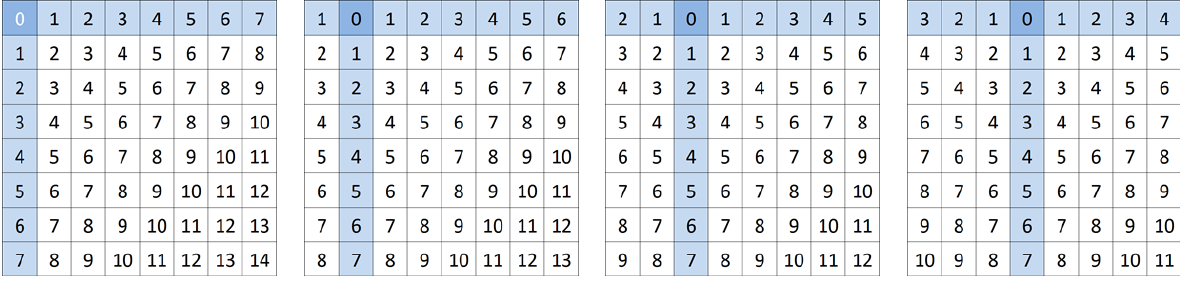
Figure 2. Number of moves required to move the blank to each position from the first half of the first row of the